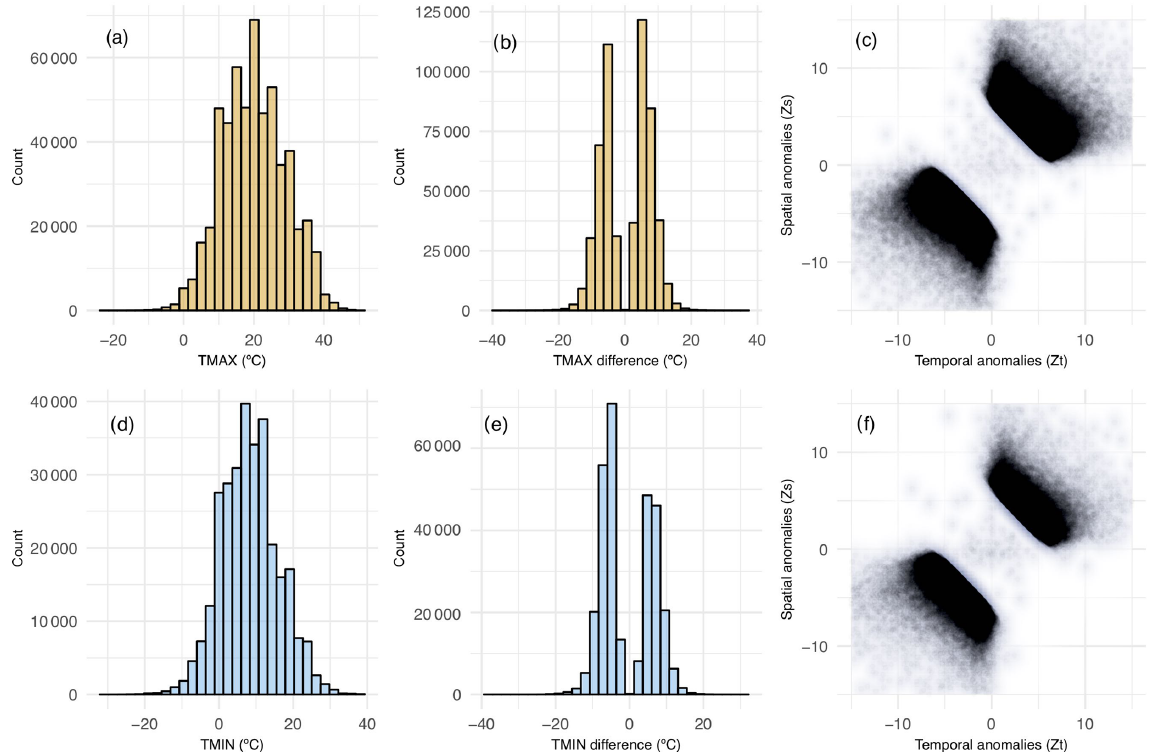
Figure 6. Daily maximum (orange, a–c ) and minimum (blue, d–f ) temperature data removed by the quality control process. (a, d) Removed data by magnitude, (b, e) removed data by differences between observations and estimates, and (c, f) temporal anomalies (Zs) vs. spatial anomalies